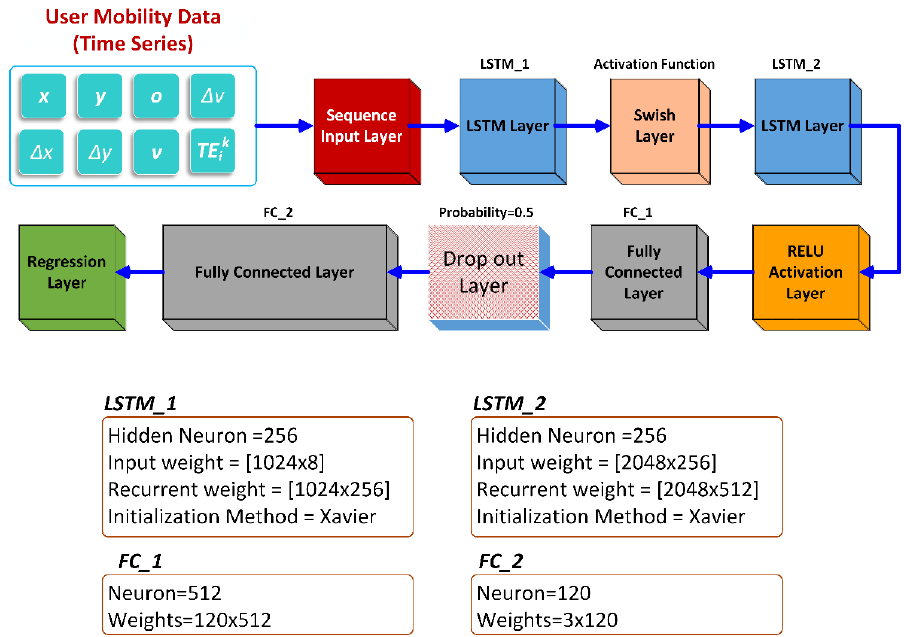
Figure 4. Location and direction prediction model (LDPM).